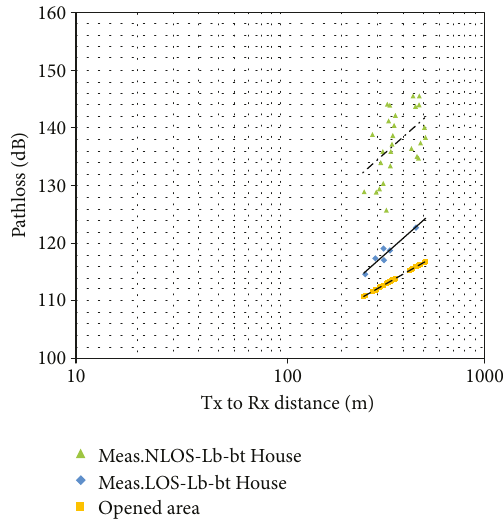
Figure 9: Pathloss characteristics according to the distance on a path coming from inter-house space (at site-speci fi